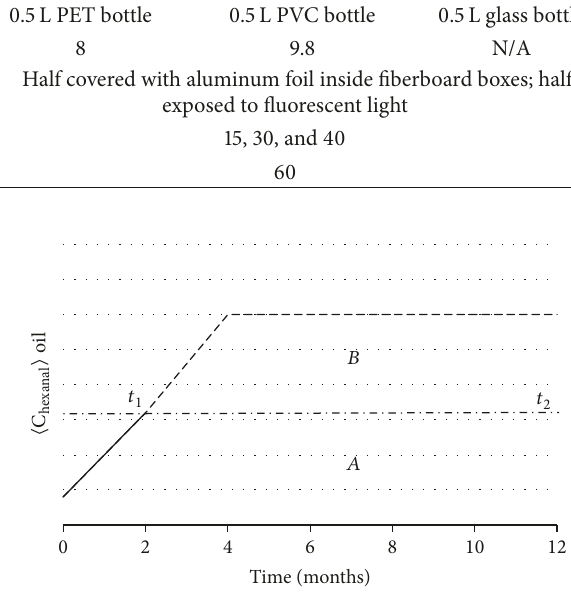
Table 6: Sample packaging and storage conditions for a 12-month study in the Coutelieris and Kanavouras (2006) model. Sample